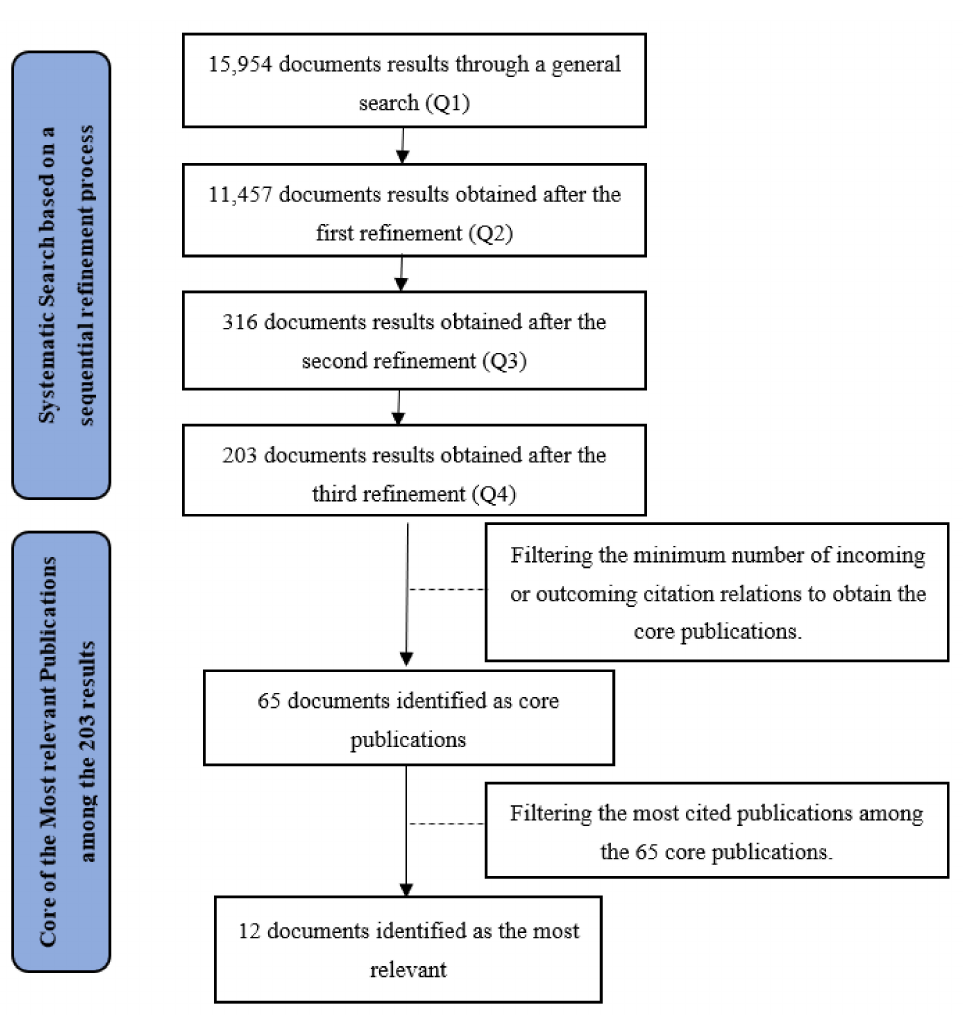
Figure 2. Flow Diagram with the different phases of the systematic review (according to Moher et al. [64] PRISMA